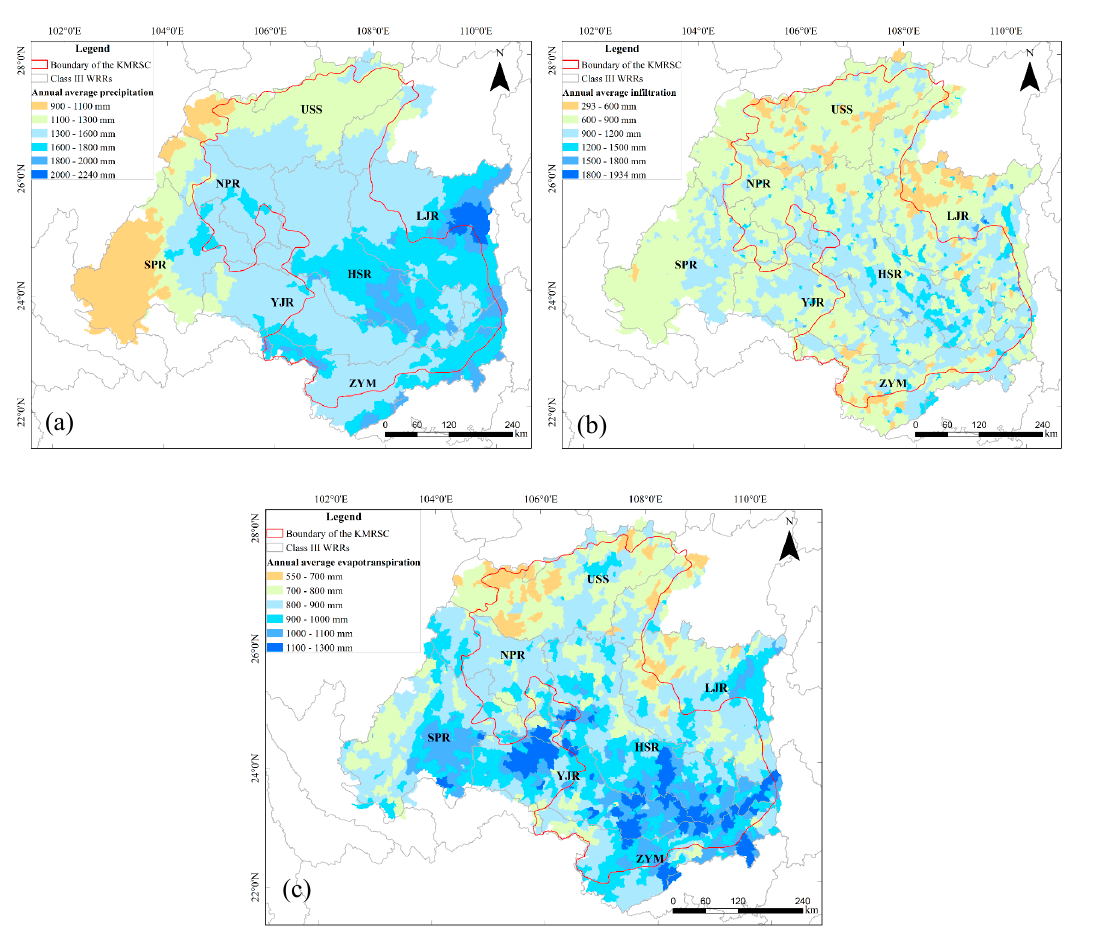
Figure 10. Spatial distribution of annual average values of main water cycle fluxes in the modelling domain: ( a ) precipitation, ( b ) infiltration, and ( c ) evapotranspiration. The seven Class III WRRs include Upstream Sina Station (USS), South Panjiang River (SPR), North Panjiang River (NPR), HongShuihe River (HSR), LiuJiang River (LJR), YouJiang River (YJR), and Zuojiang and Yujiang Main stream (ZYM). Table 5. Annual average precipitation, infiltration, and evapotranspiration in the Class III WRRs and KMRSC.